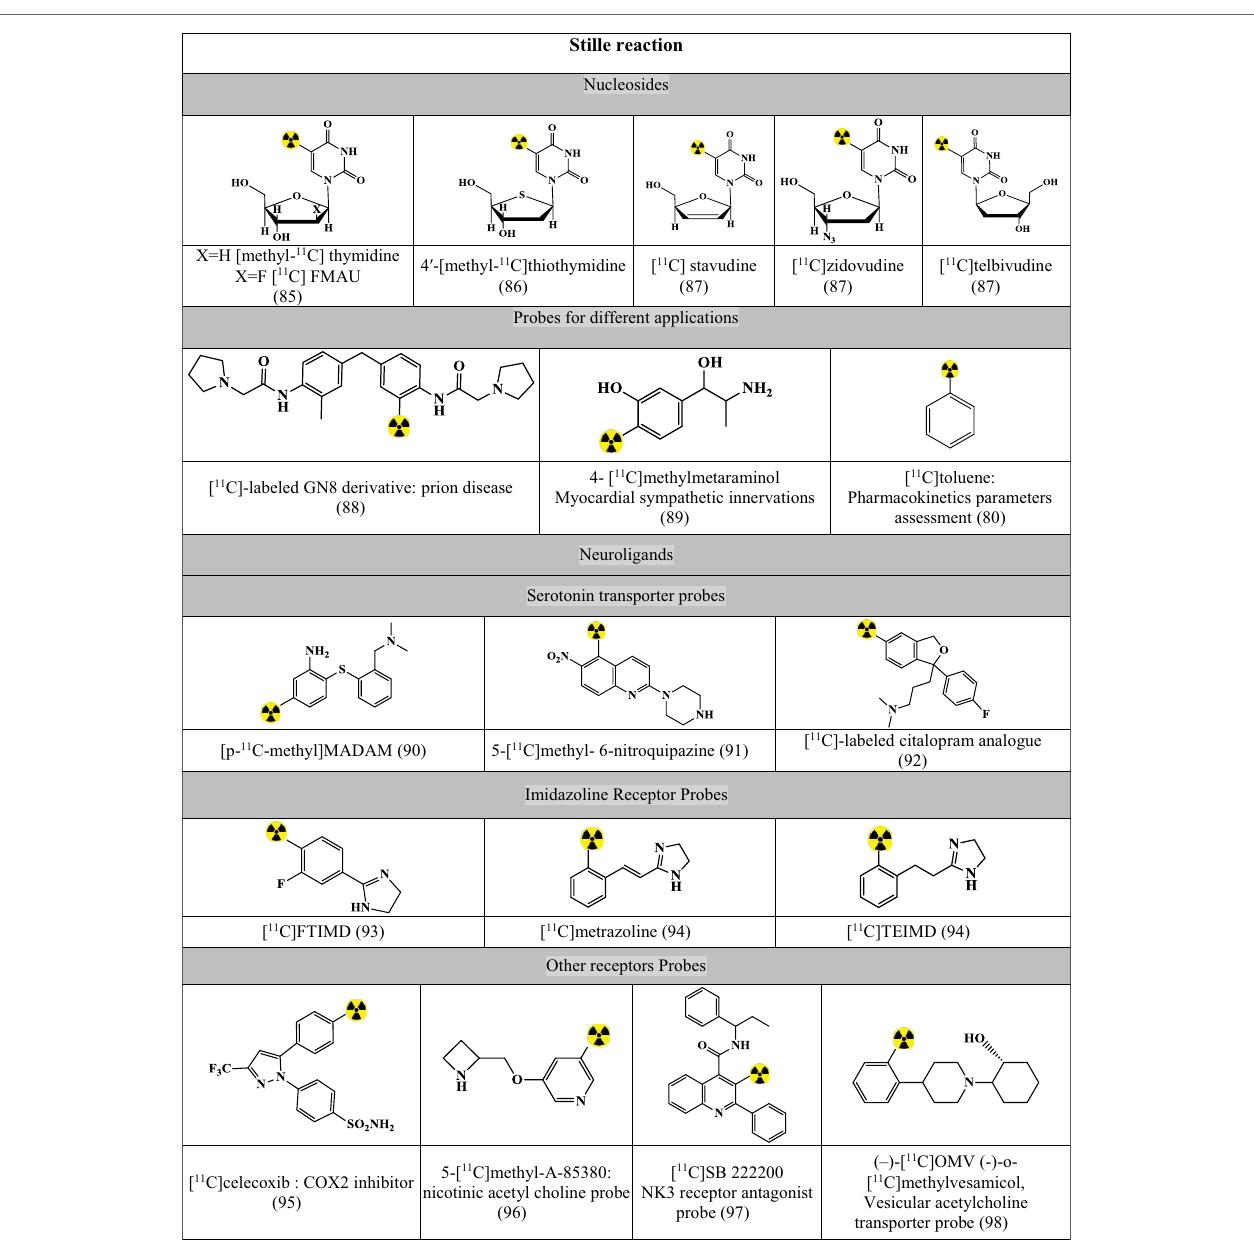
(–)-[ 11 C]OMV (-)-o- [ 11 C]methylvesamicol, Vesicular acetylcholine transporter probe